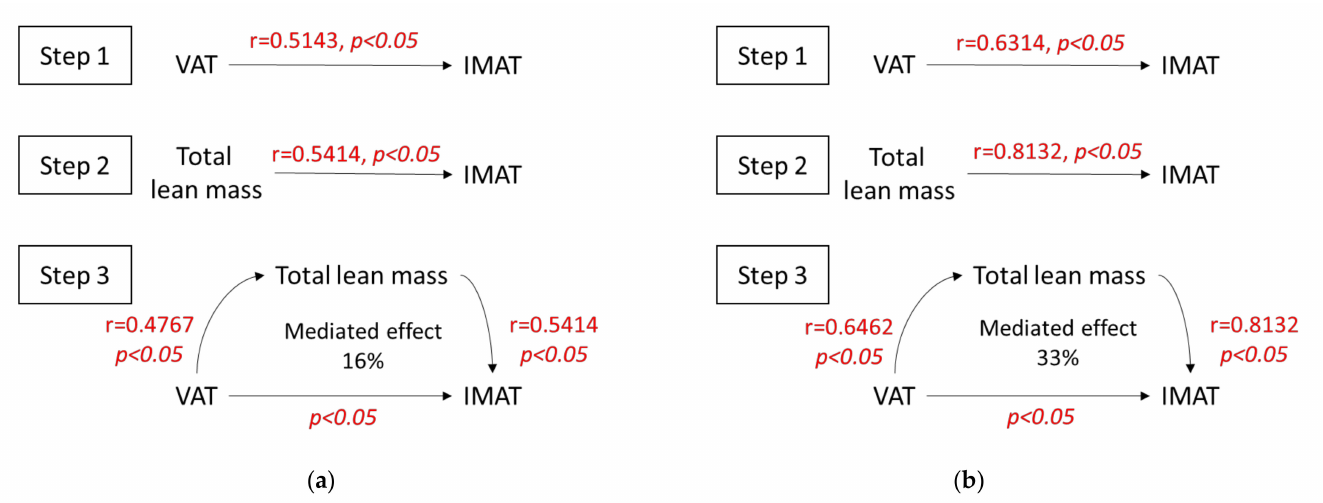
Figure 2. Mediation analysis of contributors to IMAT. Diagrams show three steps of the mediation analyses for ( a ) RA and ( b ) SpA. Tested mediator: total lean mass. Independent variable: VAT. Step 1: demonstration that VAT is correlated with IMAT. Step 2: demonstration that total lean mass is correlated with IMAT. Step 3: calculation of the influence of the mediator, total lean mass, on IMAT, after accounting for the direct effect of the independent variable,